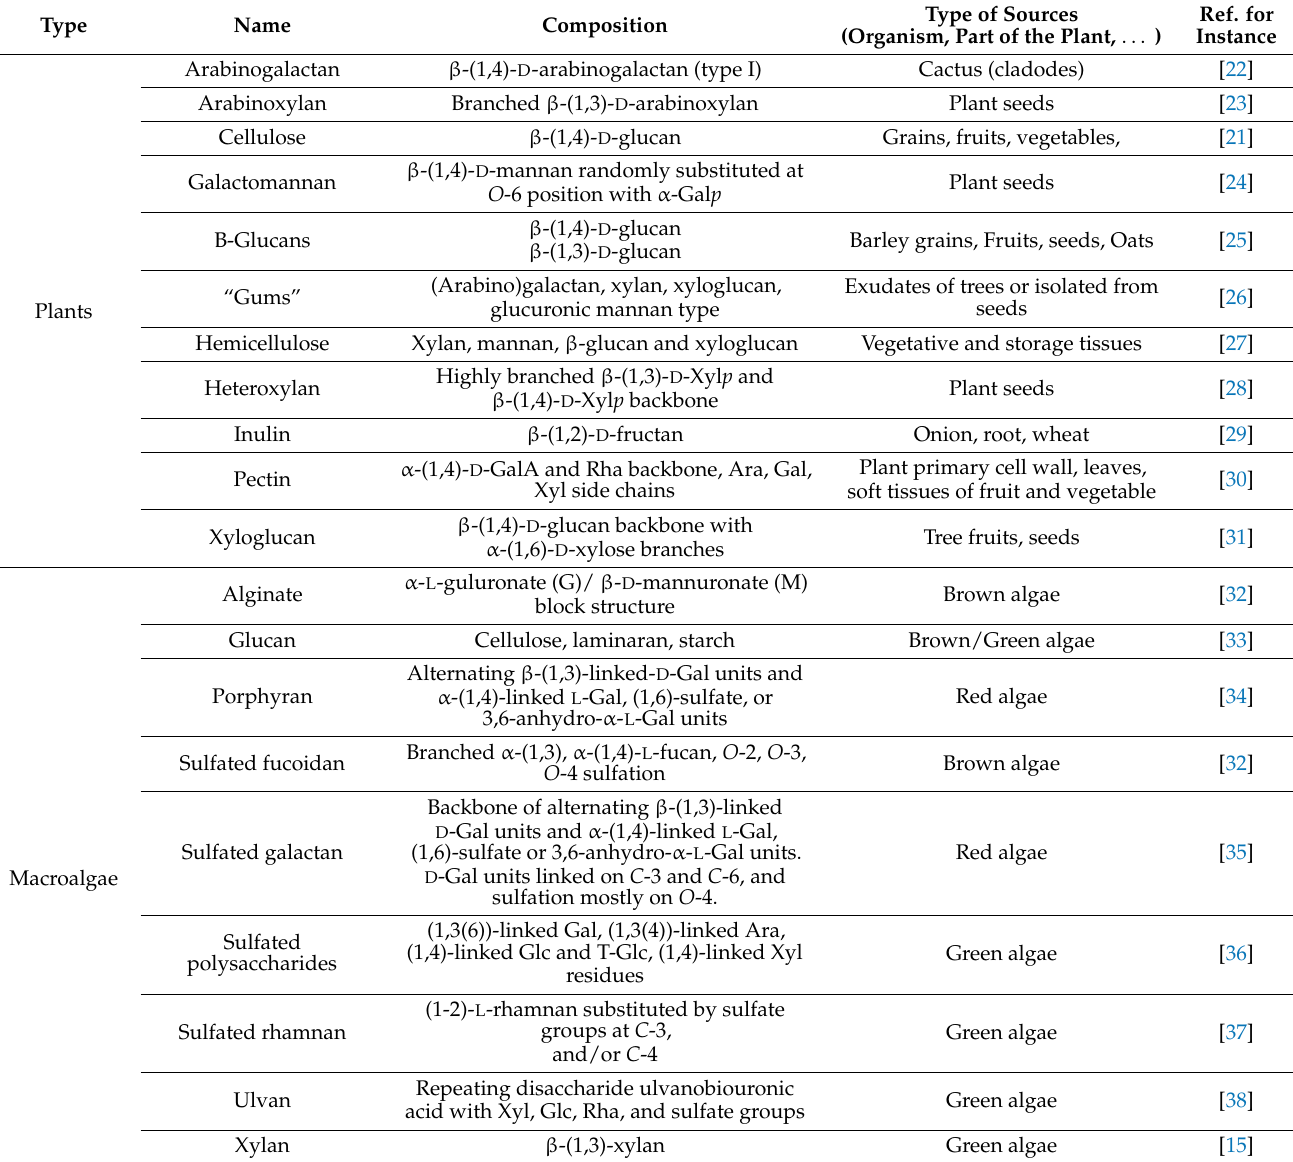
Table 1. Some polysaccharide “families” which could be extracted from African plants and macroalgae.